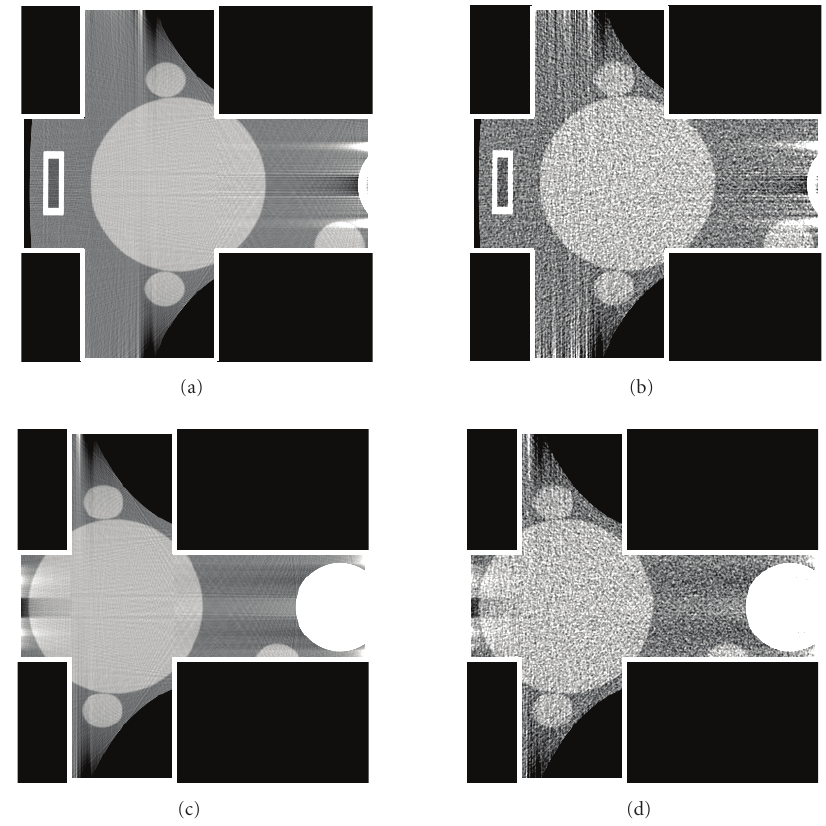
Figure 6: Reconstructed results in the cross-shaped ROIs indicated in Figures 4(b) and 4(c) using our approach. (a) and (c) are reconstructed from noise-free data. (b) and (d) are the counterpart from noisy data. The display window is